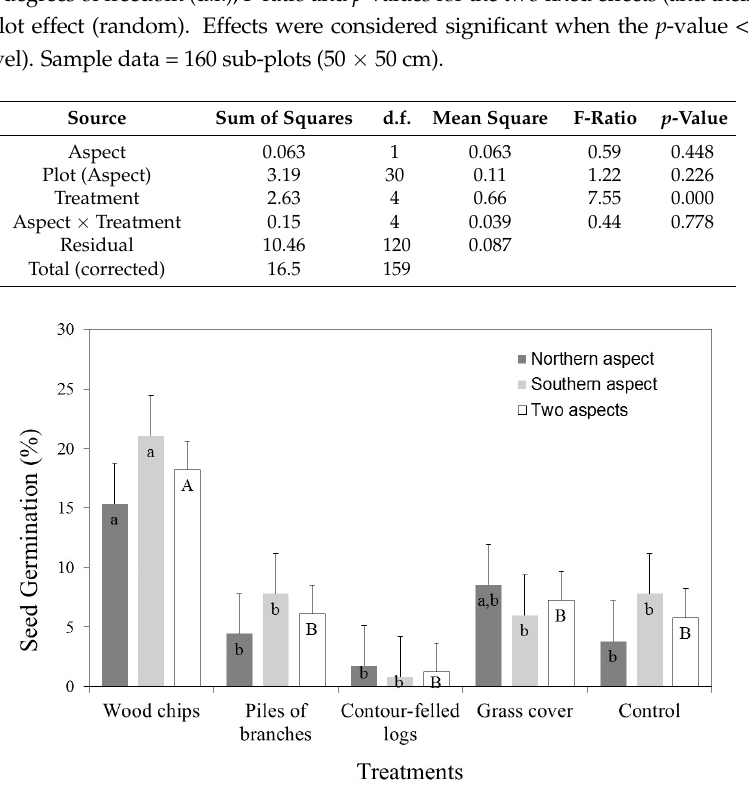
Table 3. Results of the multifactor ANOVA performed to test the statistical significance of each factor included into Model 2 that relates seedling survival (in log-transformed units) to the predictive factors. The table represents the degrees of freedom (d.f.), F-ratio and p -values ( p ) for the fixed effects (and their interaction) and for the plot effect (random). Effects were considered significant when p -value < 0.05 (95.0% confidence level). Sample data = 160 sub-plots (50 × 50 cm).